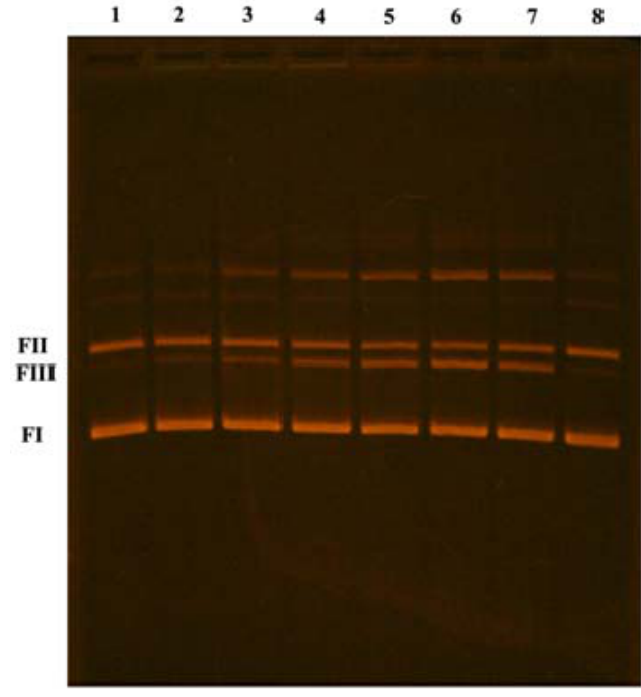
Figure 3. Agarose gel electrophoresis of plasmid pUC18 DNA. pUC18 (213 ng) without (lane 1) and pUC18 (213 ng) with 5 nmol, 10 nmol, 15 nmol, 20 nmol, 25 nmol and 30 nmol of 1 (lanes 2, 3, 4, 5, 6 and 7 respectively), pUC18 (213 ng) with acetonitrile (6 μ L) (lane